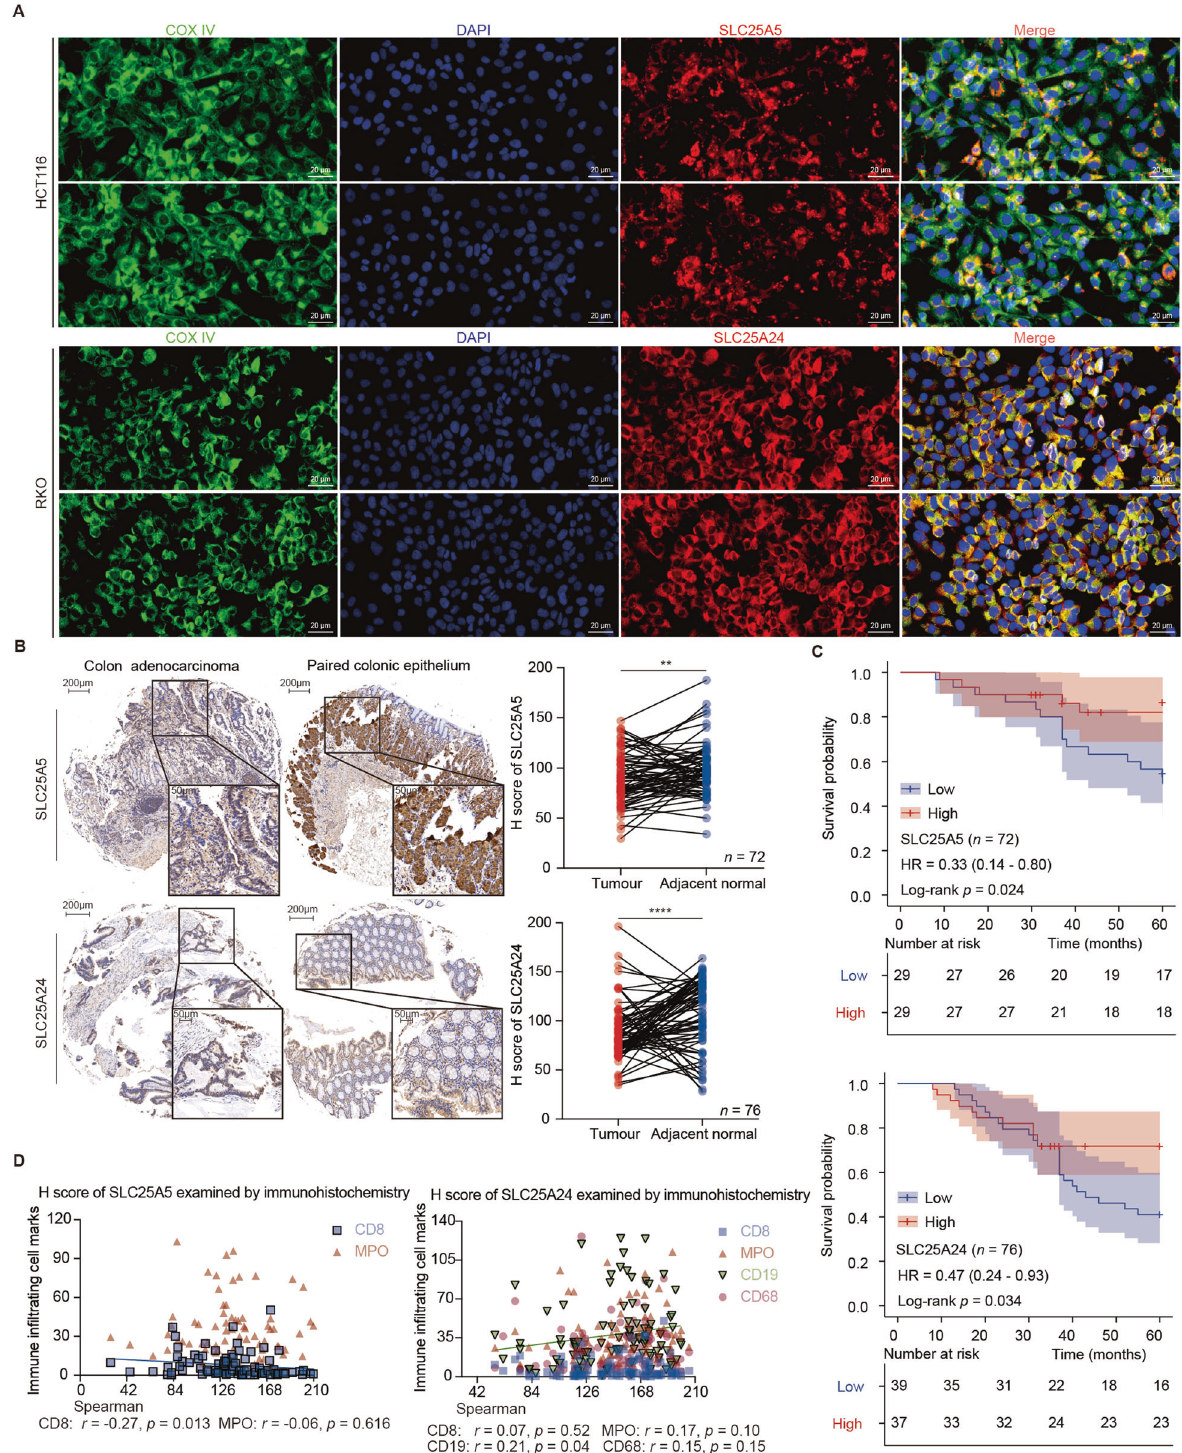
Fig. 6 Validating expression of SLC25A5 and SLC25A24 in clinical specimens of colon cancer. A Immuno fl uorescence was used to determine the location of SLC25A5 and SLC25A24 in colon cancer-derived HCT116 and RKO cells. B Immunohistochemical examinations suggested that the expression levels of SLC25A5 ( n = 72) and SLC25A24 ( n = 76) were lower in colon cancer tissues than in adjacent normal tissues in patients receiving radical surgery resection. C Kaplan – Meier survival curves suggested that patients with upregulated SLC25A5 (HR = 0.33, p < 0.05) and SLC25A24 (HR = 0.47, p < 0.05) experienced a longer survival time after surgical treatment. D Spearman correlation analyses suggested that the expression of SLC25A5 negatively correlated with that of CD8 (Spearman r = − 0.27, p < 0.05), while the expression of SLC25A24 positively correlated with that of CD19 (Spearman r = 0.21, p < 0.05). Scale bars are 20 μ m in ( A ) and 50 μ m or 200 μ m in ( B ). Statistical analysis: Student ’ s T test, ** p < 0.01, *** p <